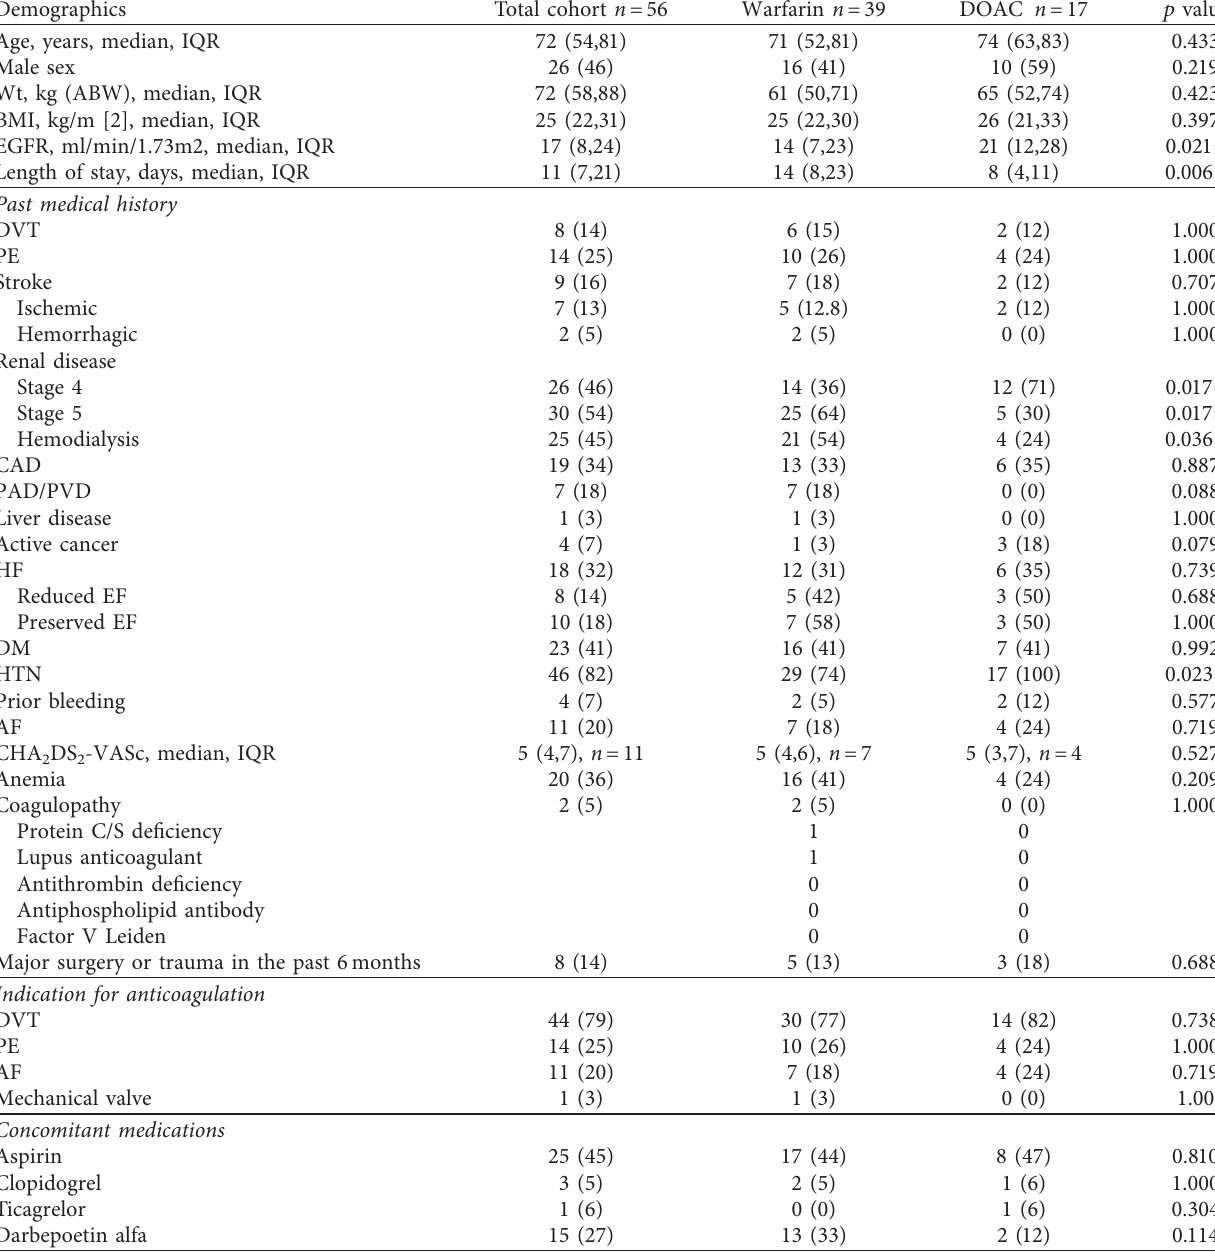
Table 1: Baseline